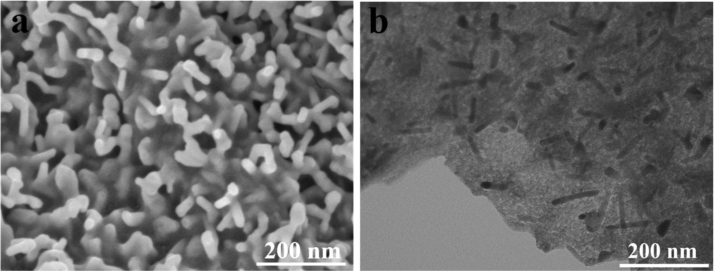
(a) SEM and (b) TEM image of Ni2P/NG/Ni2P.